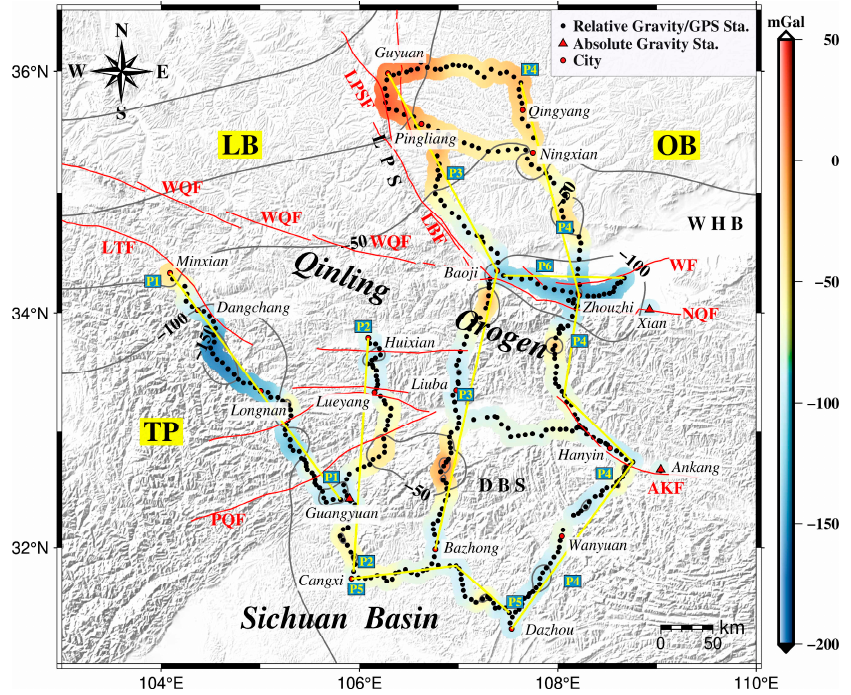
Figure 2. Free-air gravity anomaly map in the Qinling area. Abbreviations are the same as those used in Figure 1.